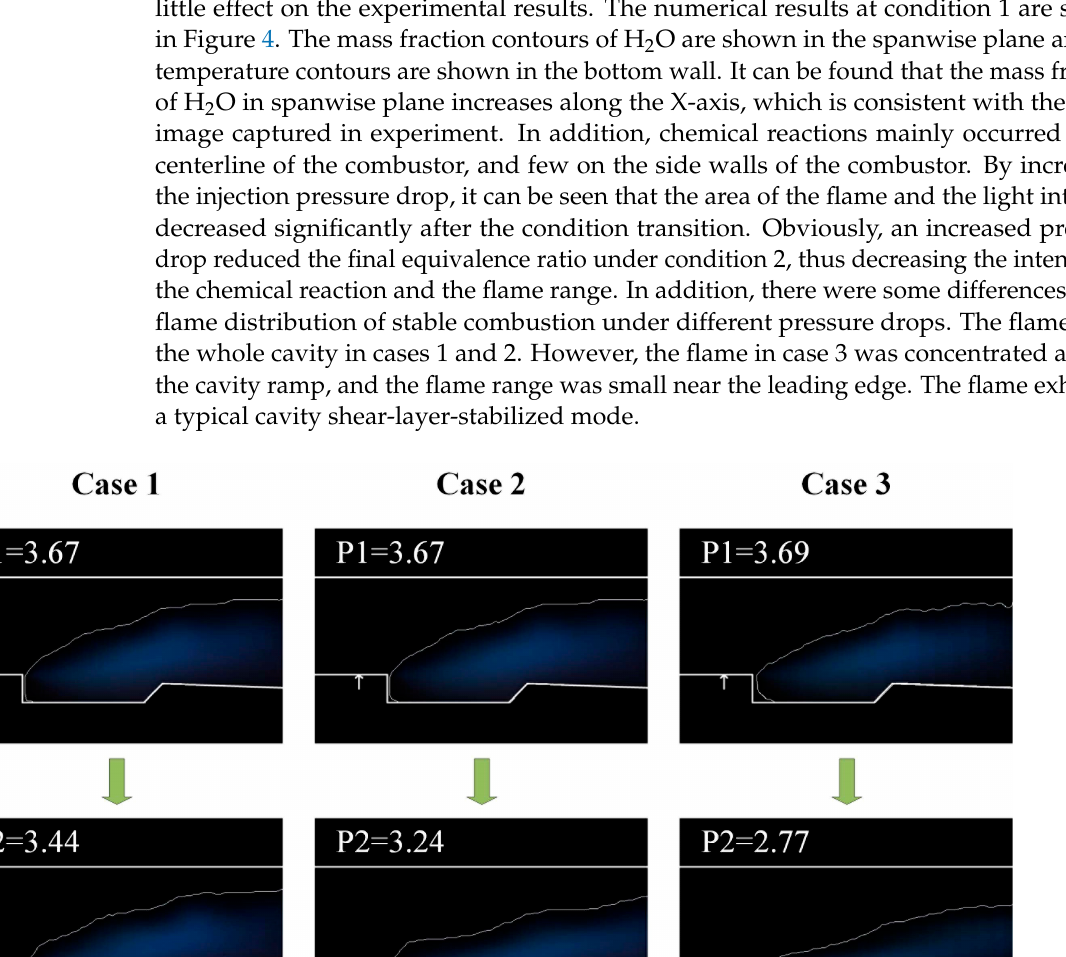
Figure 4. Mass fraction of H 2 O and temperature contours in condition 1. Figure 5 depicts the wall static pressure distribution along the bottom wall at stable combustion in two conditions for three cases. The wall pressure was uniform at each measuring position of the pressure when the combustion was stabilized in condition 1 for the three cases, which indicates that for these cases, P 1 had no influence on the results in this study. Although the wall pressure was different for each of the three cases during condition 2, the distribution trend of the wall pressure in the combustor was consistent when the combustion was stable. The wall pressure increased along the combustor and then decreased when it reached the peak value. Increasing the injection pressure drop caused the pressure in the combustor to decrease obviously after the condition transition. This was mainly due to the decrease in the equivalence ratio, which reduced the intensity of combustion. Furthermore, the wall pressure near the cavity had a more pronounced decrease than that downstream of the cavity. The position where the pressure peak appears moves downstream as P 2 decreases. This indicates that the increase in the injection pressure drop caused the decrease in combustion intensity in the cavity to be more obvious than that in the downstream area.